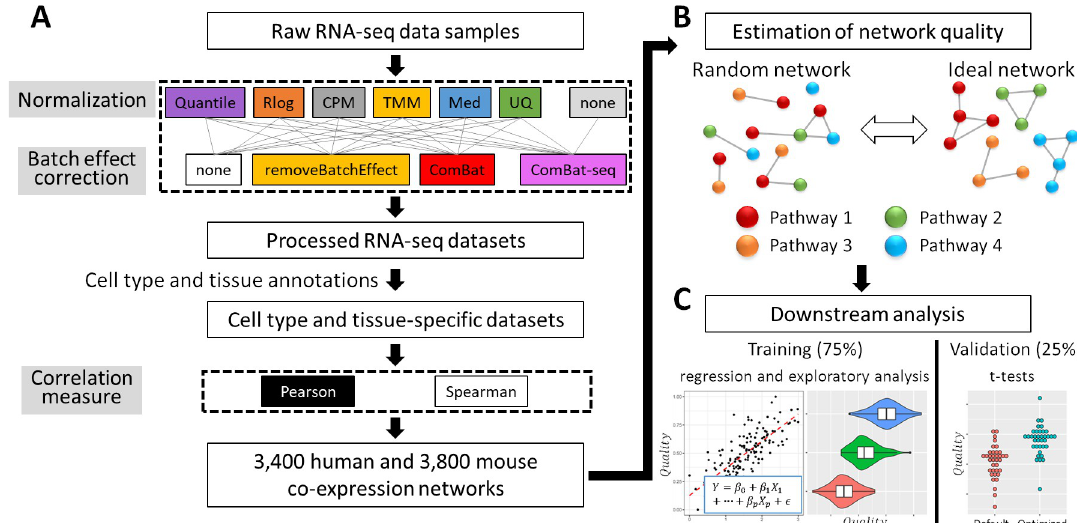
Fig 1. Summary of this study. (A) Raw RNA-seq data was processed with 50 different combinations of normalization, batch effect correction, and correlation measures into 7,200 genome-wide sets of cell type and tissue-specific co-expression predictions, which we refer to as “co-expression networks”. (B) Quality of co-expression networks was estimated based on the enrichment of functional annotations of correlated genes and regulatory motifs in their promoters. In random co-expression networks no common annotations and motifs are expected to be found among correlated genes. In contrast, in ideal networks such enrichments should be encountered frequently. Here nodes represent genes and edges co-expression. (C) Quality measures were processed into 7,200 quality scores, which were used for downstream analysis. We use 75% of cell types and tissues for regression and exploratory analysis, and the remaining 25% for validation.